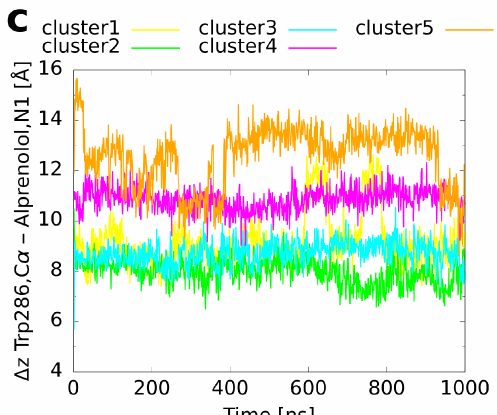
Figure 7. Binding CV ( z distance between the Trp 6.48 C α atom and the ligand’s amine/amino nitrogen atom) as a function of simulation time in the unbiased MD simulations of the cluster